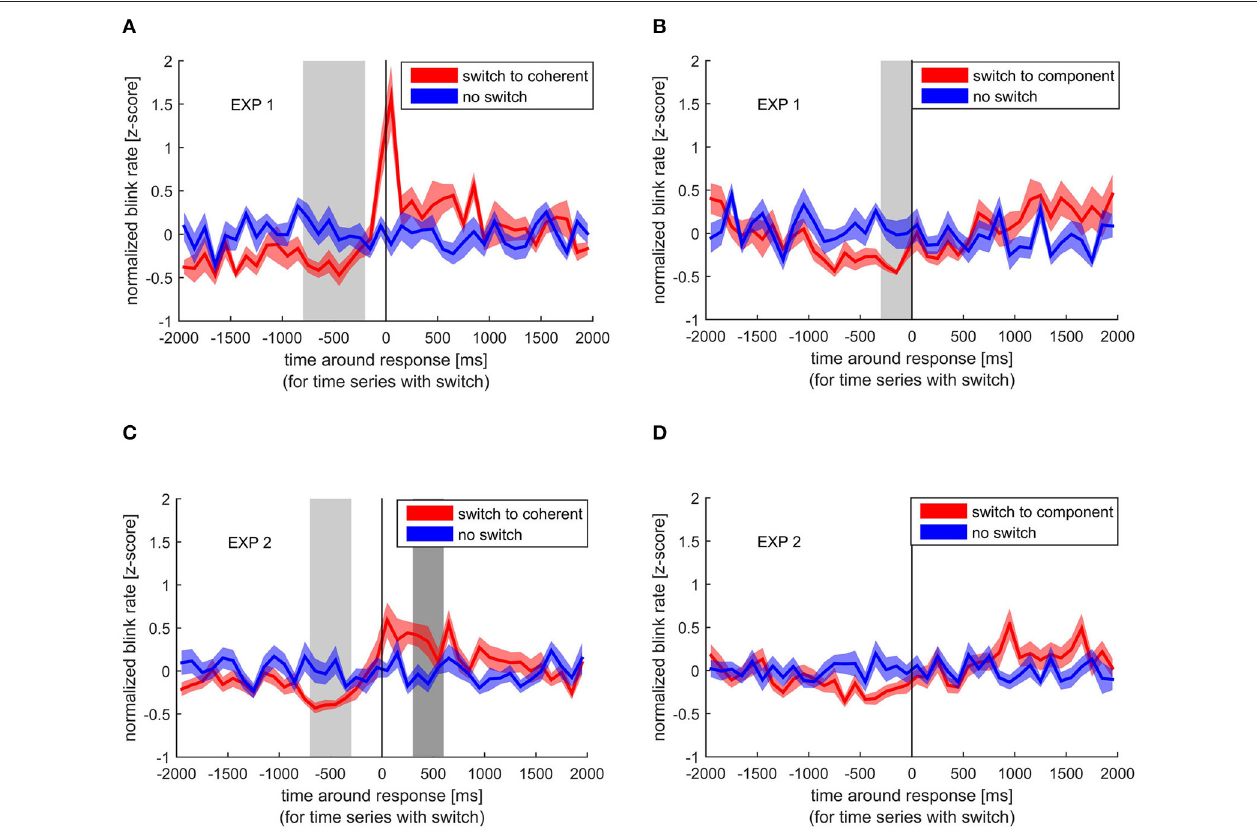
FIGURE 2 | Normalized blink rate around the response indicating a perceptual switch (red) compared with the normalized blink rate during no switch (blue). Colored lines and ribbons represent mean ± standard error of the mean (SEM). Vertical shaded areas mark significant time points revealed by the non-parametrical statistical test procedure described by Maris and Oostenveld (2007). (A) Switch to coherent motion in experiment 1. (B) Switch to component motion in experiment 1. (C) Switch to coherent motion in experiment 2. (D) Switch to component motion in experiment